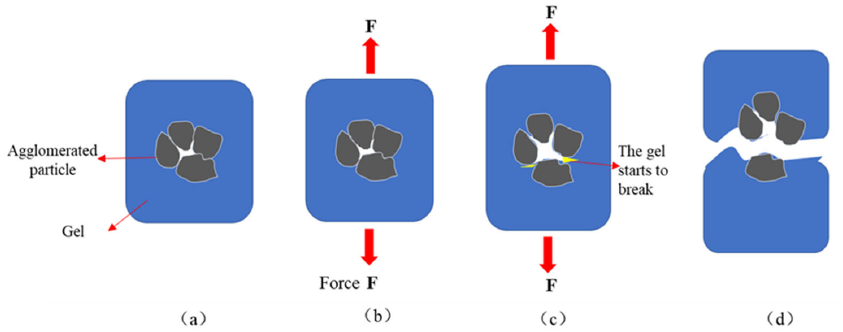
Figure 4. Schematic diagram of tensile fracture process in IPN@zeolite powder cross-linked gel. ( a ) The agglomerated particles are coated by gel; ( b ) The gel is pulled; ( c ) The gel began to break from the agglomerated particles; ( d ) The gel is stretched and broken.